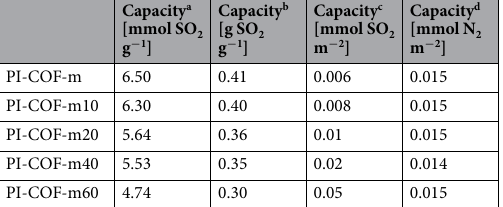
Table 1. SO 2 sorption capacities of the PI - COF - m X series. a Mmol SO 2 /g sorbent at 25 °C. b G SO 2 /g sorbent at at 25 °C. c Mmol